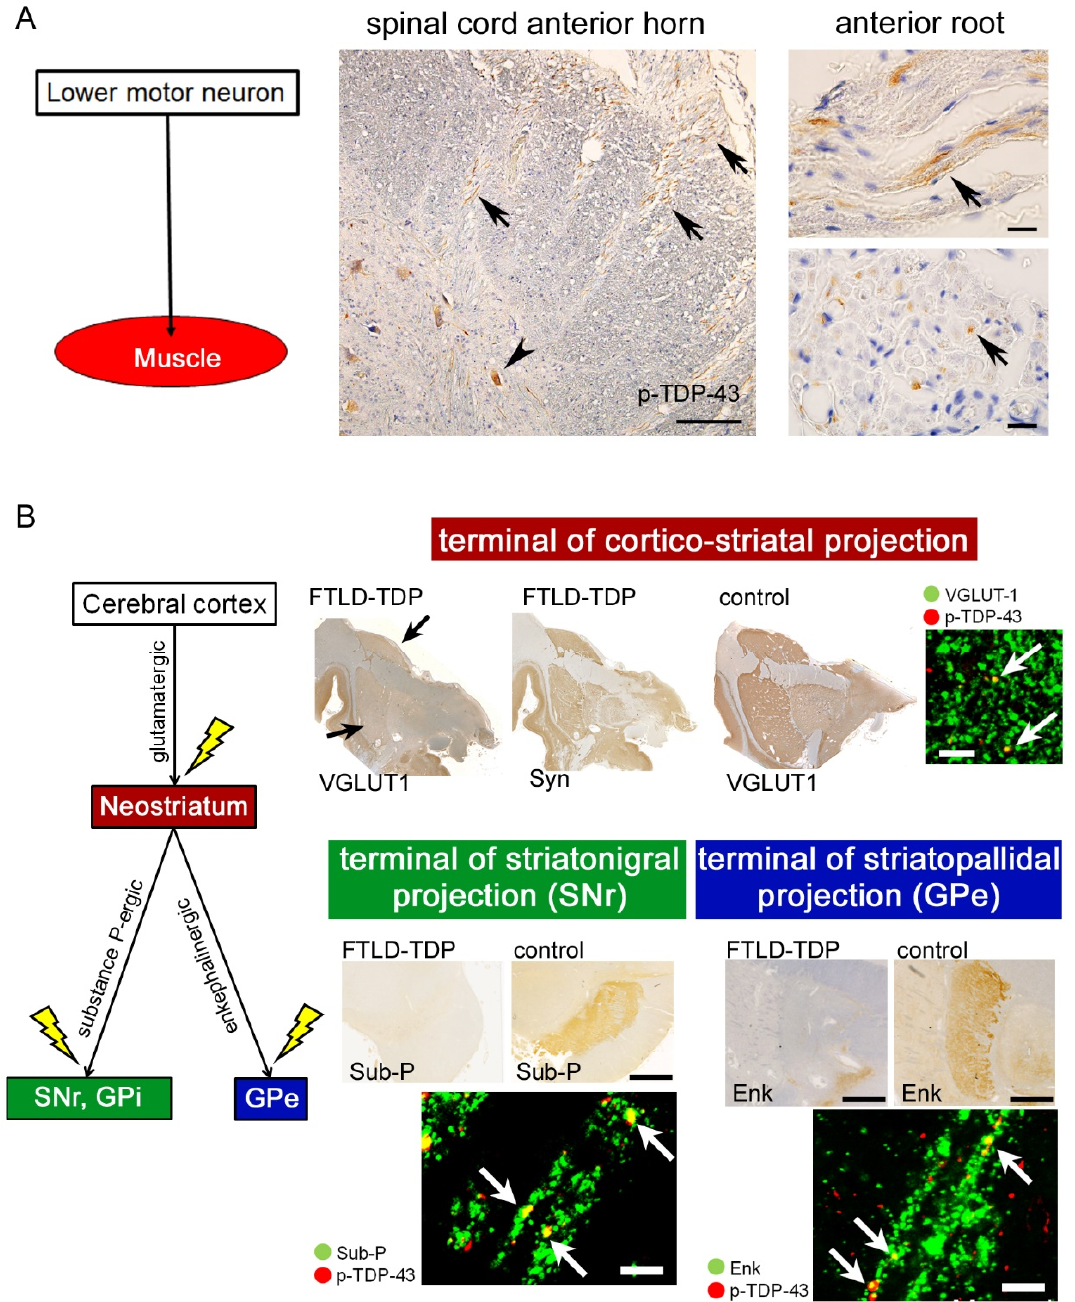
Figure 3. TDP-43 pathology in multi-system axons and axon terminals. The upper section ( A ) demonstrates the spinal cord of an ALS-TDP patient who died six months after the disease onset. Phosphorylated TDP-43 (p-TDP-43) aggregated not only in the anterior horn neurons (arrowhead) but also in the anterior roots (arrows). Scale bars: 100 μm for the panel of the anterior horn and 10 μm for the panels of the anterior roots. The lower section ( B ) displays pathologic changes of the cortico-striatal circuit in FTLD-TDP patients. Axon terminals of the corticofugal neurons were visualized with anti-VGLUT-1 immunohistochemistry (IHC) in the neostriatum. Those of the striatofugal neurons were labeled with anti-enkephalin (Enk) IHC in the external segments of the globus pallidus (GPe) or with anti-substance-P (Sub-P) IHC in the internal segment of GP (GPi) and pars reticulata of the substantia nigra (SNr). Patients with FTLD-TDP displayed loss of those axon terminals and p-TDP-43 aggregation within the pre-synaptic buttons. Comparing the loss of VGLUT-1-immunopositive terminals in the neostriatum (arrows) and sparing of synaptophysin (Syn) immunostaining indicates specific loss of cortico-striatal projections but spares of other projections. Scale bars: 10 μm.